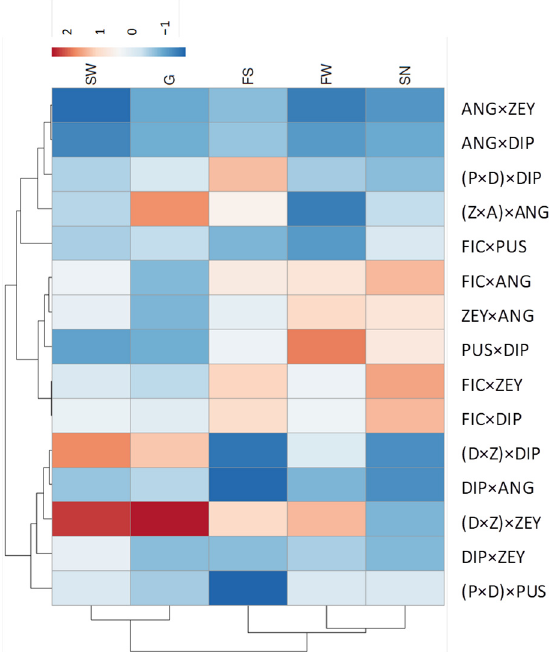
Figure 4. Heatmap of post-zygotic IRBs acting at different reproductive stages in interspecific crosses. Estimated parameters (columns) include seed weight (SW), germination rate (G), fruit set % (FS), fruit weight (FW), and seed number (SN). Interspecific crosses (rows) include those producing at least one fruit. Values for each parameter were estimated relative to seed parent intraspecific controls. The color range from red to blue represents weaker to stronger IRBs to